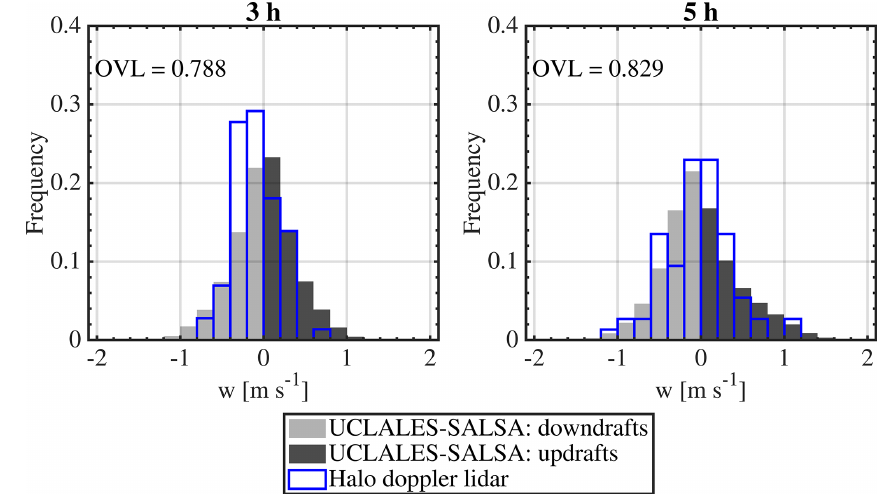
Figure 4. Comparison of model-based distributions of vertical wind at cloud base during case 1 24 September 2020 to those retrieved from Doppler lidar observations. Each panel shows the overlapping index value (OVL) as an indicator of agreement between distributions.